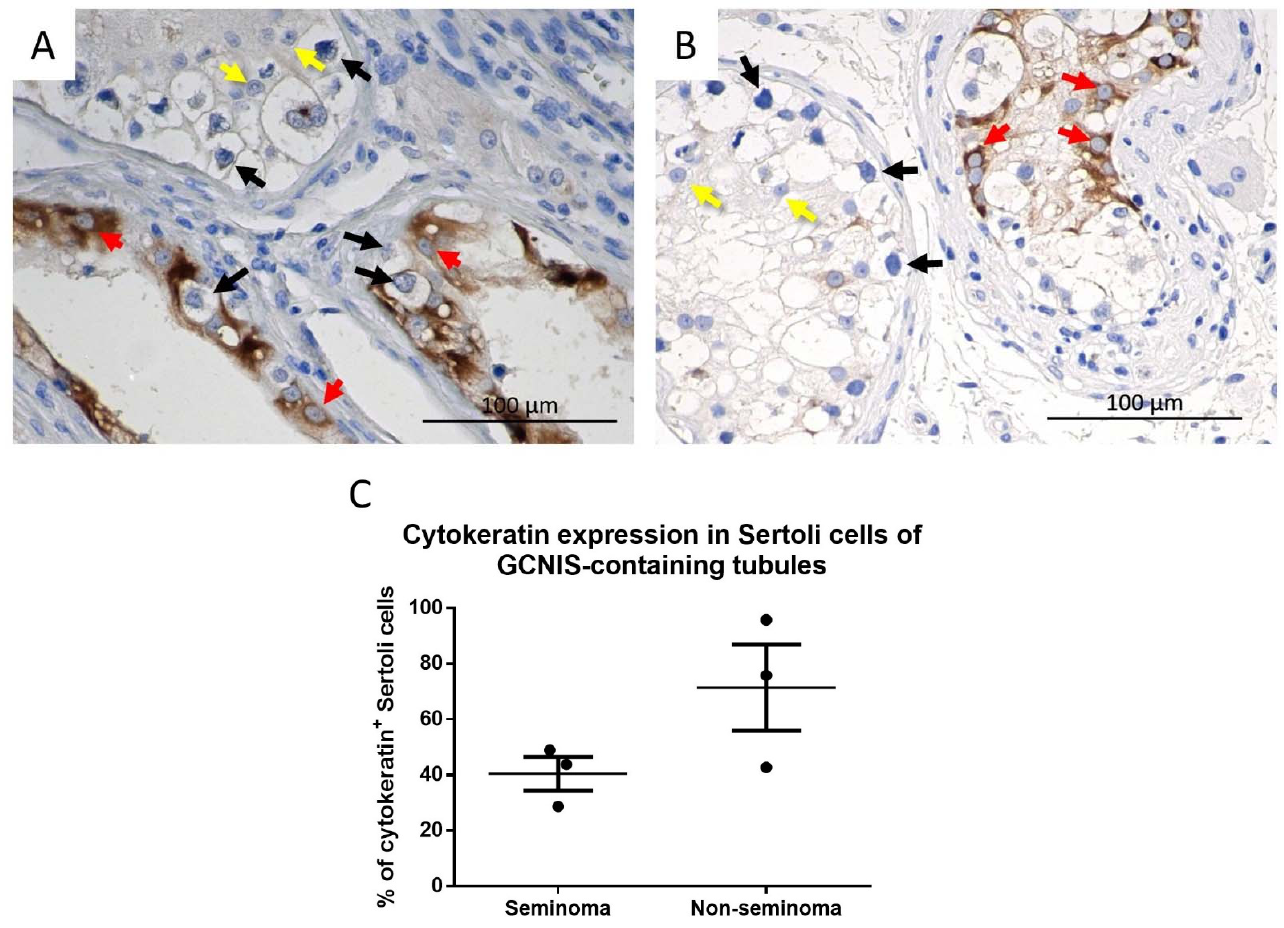
Figure 6. Cytokeratin expression in GCNIS containing tubules from a ( A ) seminoma and ( B ) non ‐ seminoma patient. Red arrows: cytokeratin + Sertoli cells, yellow arrows: cytokeratin − Sertoli cells, black arrows: GCNIS. ( C ) Semi ‐ quantitative analysis of cytokeratin + Sertoli cells of GCNIS containing tubules from seminoma and non ‐ seminoma patients. Mean ± SEM, data analysed by unpaired t ‐ test.